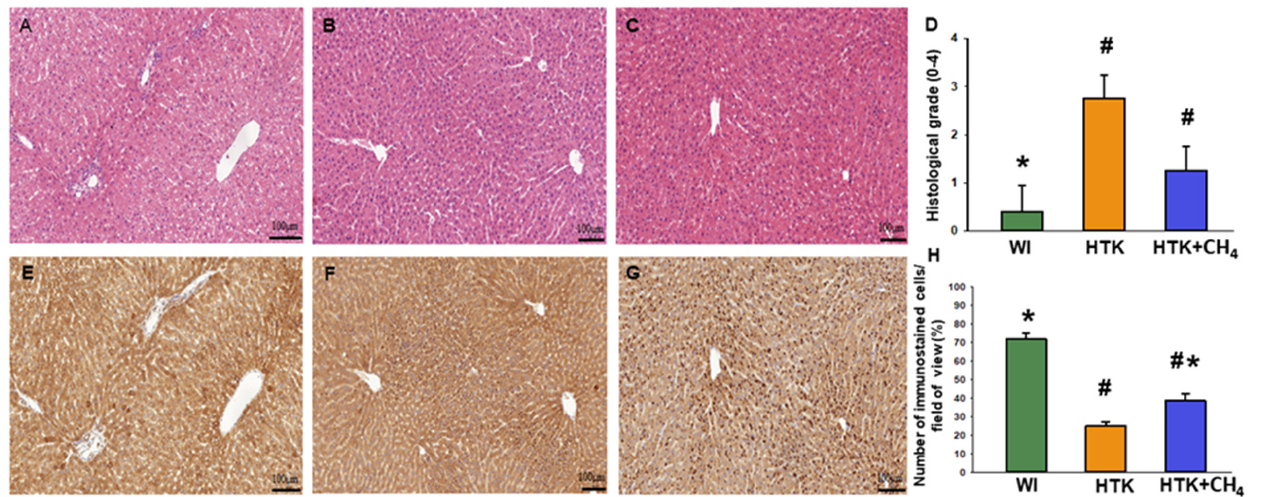
Figure 7. Histology and immunohistochemistry. ( A , E ) The WI group, ( B , F ) the HTK group and ( C , G ) the HTK-CH 4 group. The bar represents 100 µ m. ( D ) Histological grading of groups represents a composite of number of damaged hepatocytes ( n = 15–18). Histological sections were stained with hematoxylin and eosin. Morphological liver integrity was graded according to criteria developed for IPRL livers on a scale of 1 (excellent) to 5 (poor) described as follows: (1) normal rectangular structure, (2) rounded hepatocytes with increased sinusoidal spaces, (3) vacuolization, (4) nuclear pyknosis and (5) necrosis. Endothelial cell injury was classified by the degree of cell detachment from the vascular matrix discriminating between arterioles, large veins and small venules ( H ). Immunostained cells in the field of view plotted as a percentage. The WI group is marked green, the HTK group is marked yellow, and the HTK + CH 4 group is marked blue. Data are presented as means ± SD. * p < 0.05 vs. WI; # p < 0.05. vs. HTK.